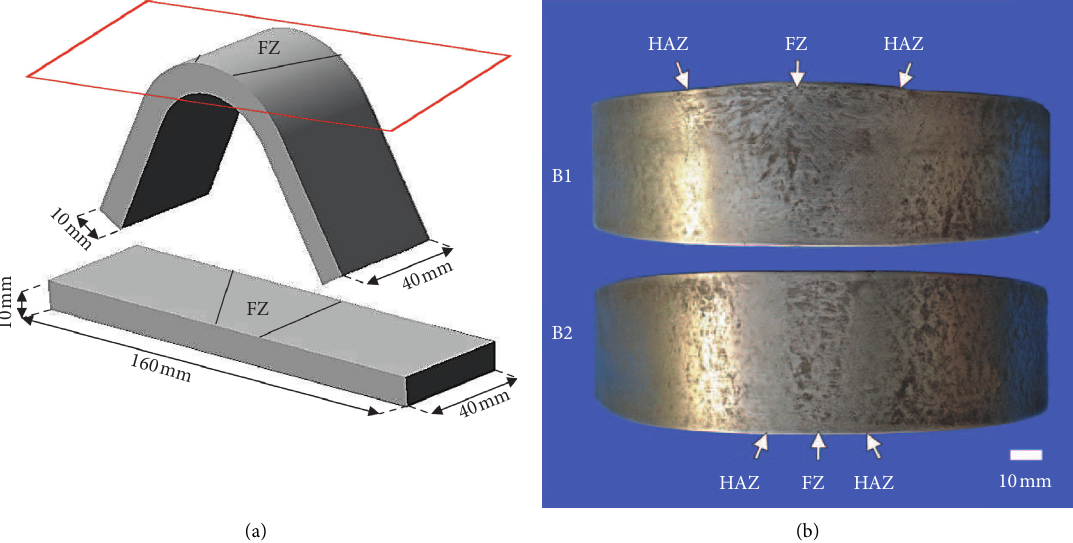
Figure 12: Outer surface of the side bend tested samples of the EB butt weld.